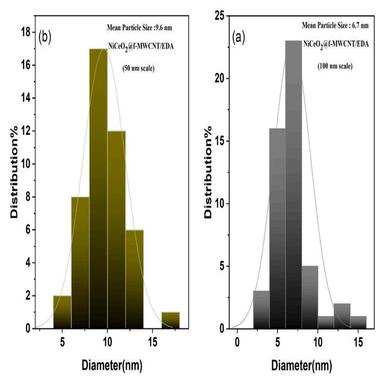
Particle histograms obtained using TEM analyzes at different scales 50 nm (a) and 100 nm (b) for NiCeO2@f-MWCNT/EDA nanoparticles.